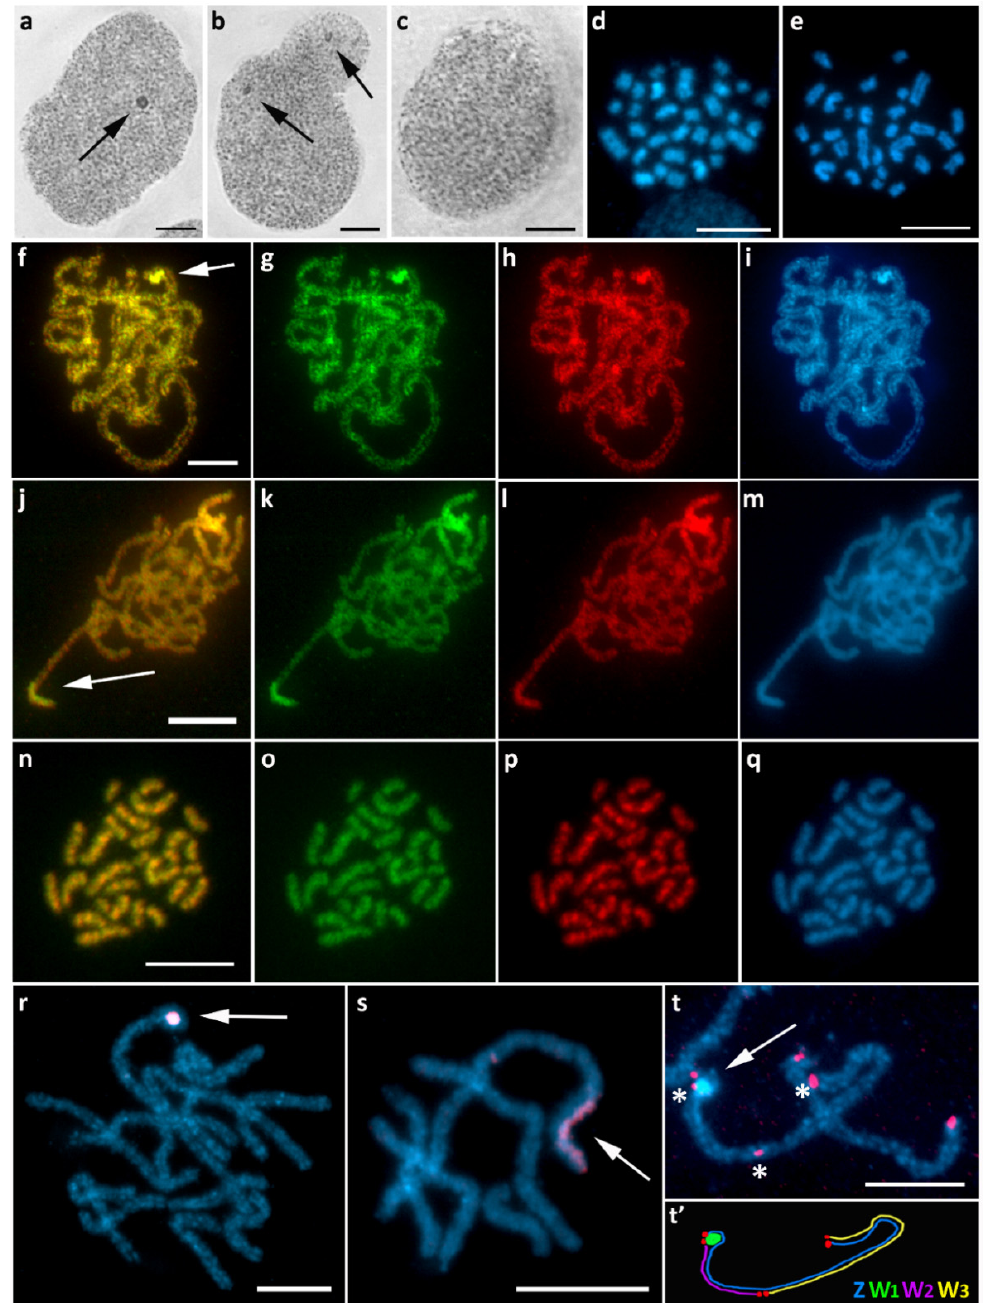
Figure 7. Sex chromosome multivalent and reduced chromosome number in Operophtera bru- mata . ( a – c ) Polyploid nuclei stained with orcein showing a single conspicuous sex chromatin body (( a ), arrow) and occasionally two bodies ( b , arrows) in females, but no sex chromatin in males ( c ). ( d , e ) Mitotic chromosomes stained with DAPI showing 2 n = 30 in females ( d ) and 2 n = 28 in males ( e ). ( f – m ) CGH on female pachytene chromosomes identified a terminal W chromosome segment, either forming a heterochromatin body ( f – i , arrow) or a short region paired with the Z chromosome (( j – m ), arrow), highly differentiated with the female genomic probe, but also highlighted with the male genomic probe. ( n – q ) No differentiated regions were found after CGH on male mitotic chromo- somes. ( r , s ) FISH with the W 1 -painting probe showing two forms of the W 1 chromosome, condensed (( r ), arrow) and stretched (( s ), arrow). ( t , t’ ) FISH with the (TTAGG) n telomeric probe revealed a sex chromosome quadrivalent consisting of a fully differentiated W 1 chromosome (( t ), arrow) and